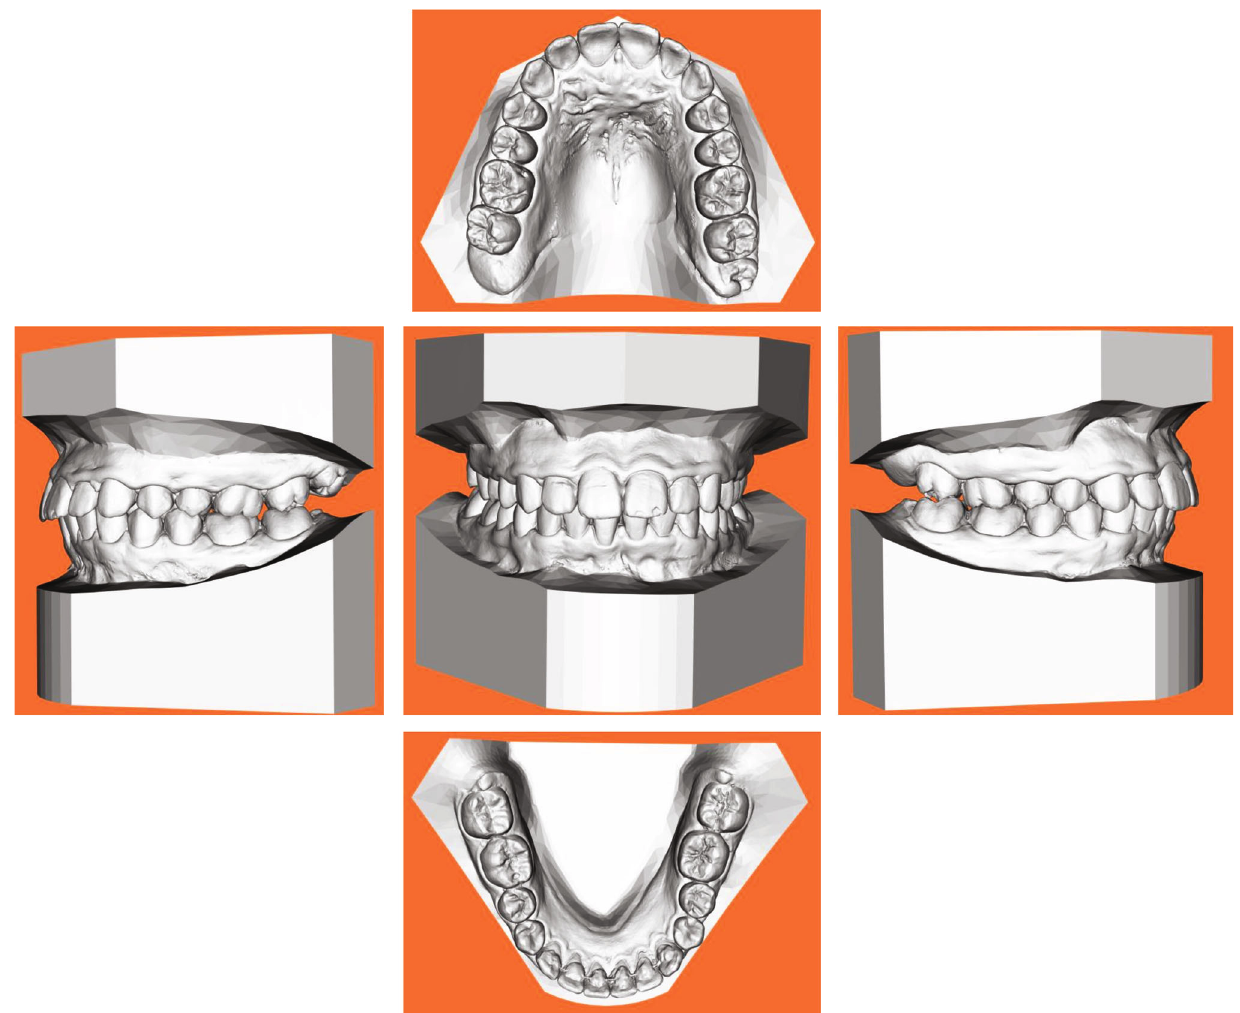
Figure 17: Final digital model.